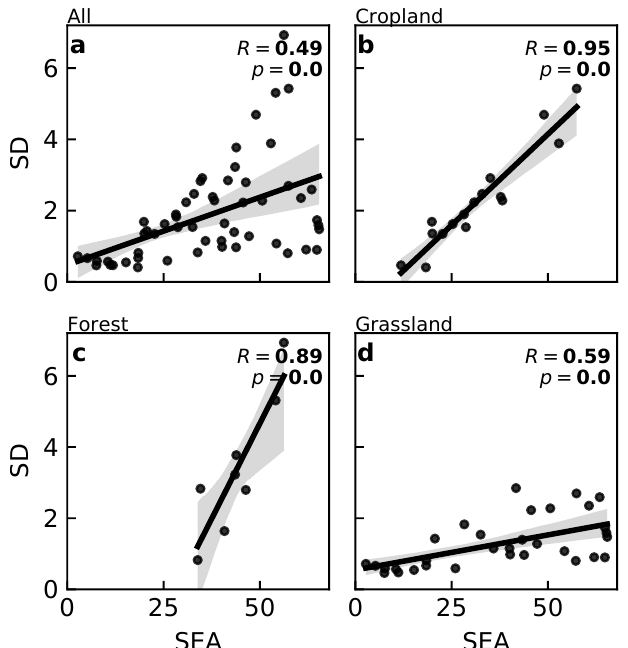
Figure A2. Correlation of sun elevation angle and standard deviation per land cover type. ( a ) All; ( b ) Cropland; ( c ) Forest; ( d ) Grassland.